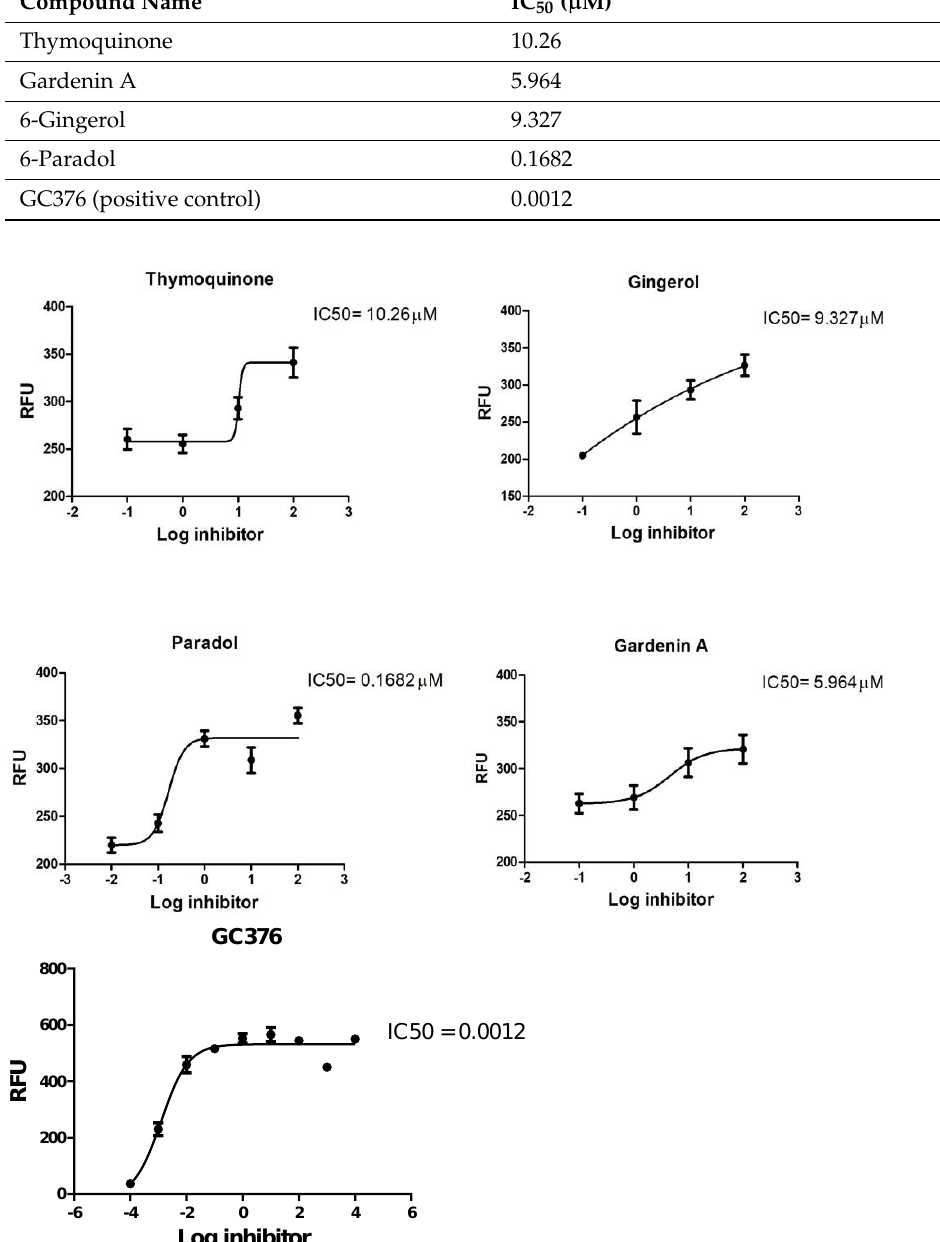
Figure 2. Inhibition of M PRO protease enzyme activity by isolated Figure 2 . Inhibition of M PRO protease enzyme activity by isolated compounds.